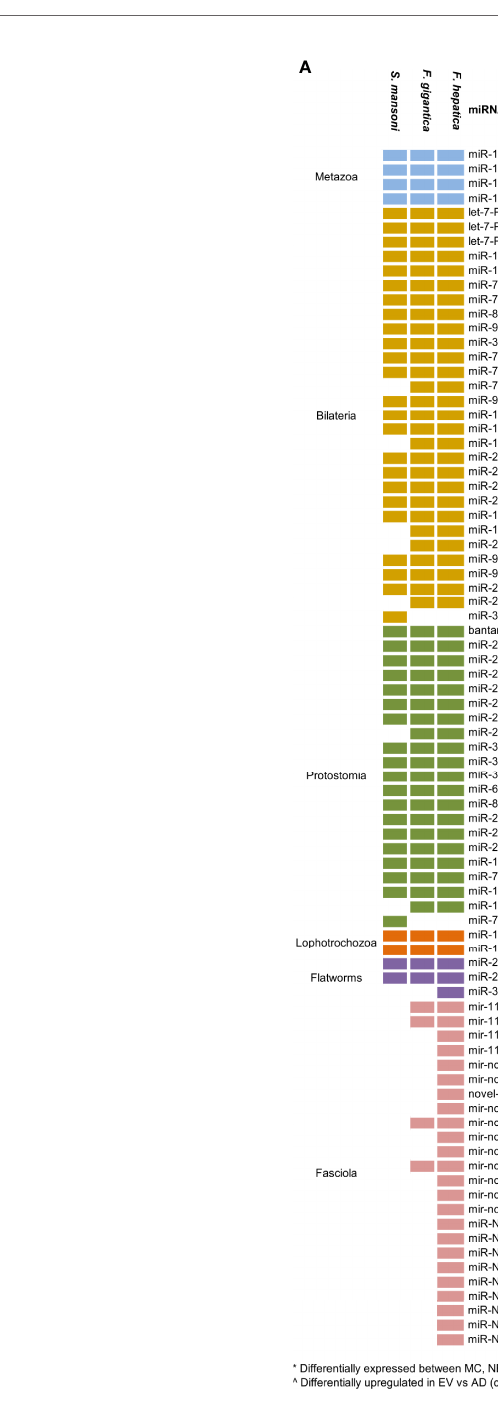
FIGURE 2 | MiRNA complement and relative abundance across species and stages. (A) Updated miRNA complements in F . hepatica , F . gigantica and S. mansoni . individual miRNAs belonging to the same miRNA family have the same id plus an individual precursor number. Shaded blocks indicate evolutive conservation across: Metazoan (light blue), Bilateria (yellow), Protostomia (green), Lophotrochozoa (orange), fl atworms (purple) or Fasciola species (pink). Empty (white) blocks indicate that the miRNA has not been detected in the species (B) Heatmap depicting the comparative abundance of individual miRNAs between MC, NEJ, AD stages, and the adult EV fraction. Read counts were normalized to count per million (CPM) and color scale was applied. White shaded blocks indicate lower expression, darker colors indicate high abundance. (*) Indicates signi fi cant variations between cellular fractions of MC, NEJ, and AD (FDR ≤ 0.01 & Log2FC ≥ 2). (^) Indicates signi fi cantly upregulated in the EV fraction respect to the somatic fraction of AD (FDR ≤ 0.01 & Log2FC ≥ 2). A histogram with the average expression of each miRNA shows that only a reduced set are always